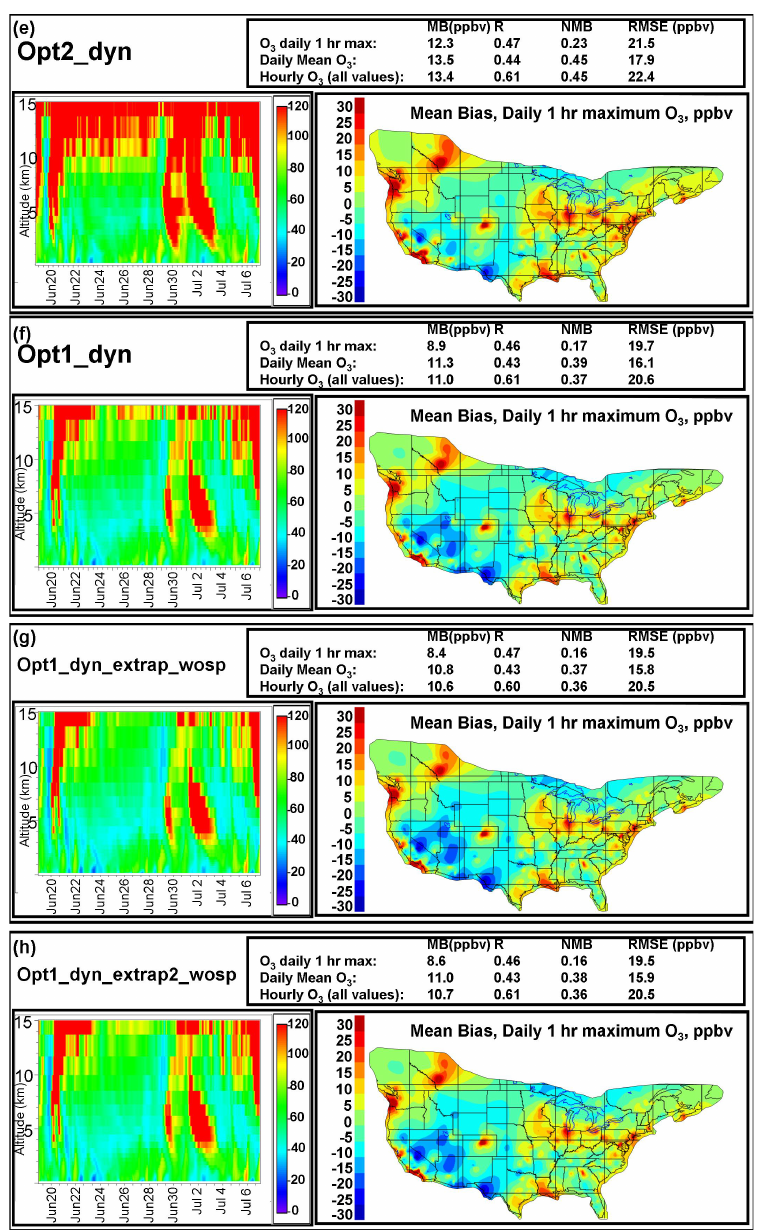
Fig. 5. (e) and (f) : As in (a) and (b), but for Opt2 dyn and Opt1 dyn methodologies. (g) and (h) As in (a) and (b), but for Opt1 dyn extrap wosp and Opt1 dyn extrap2 wosp